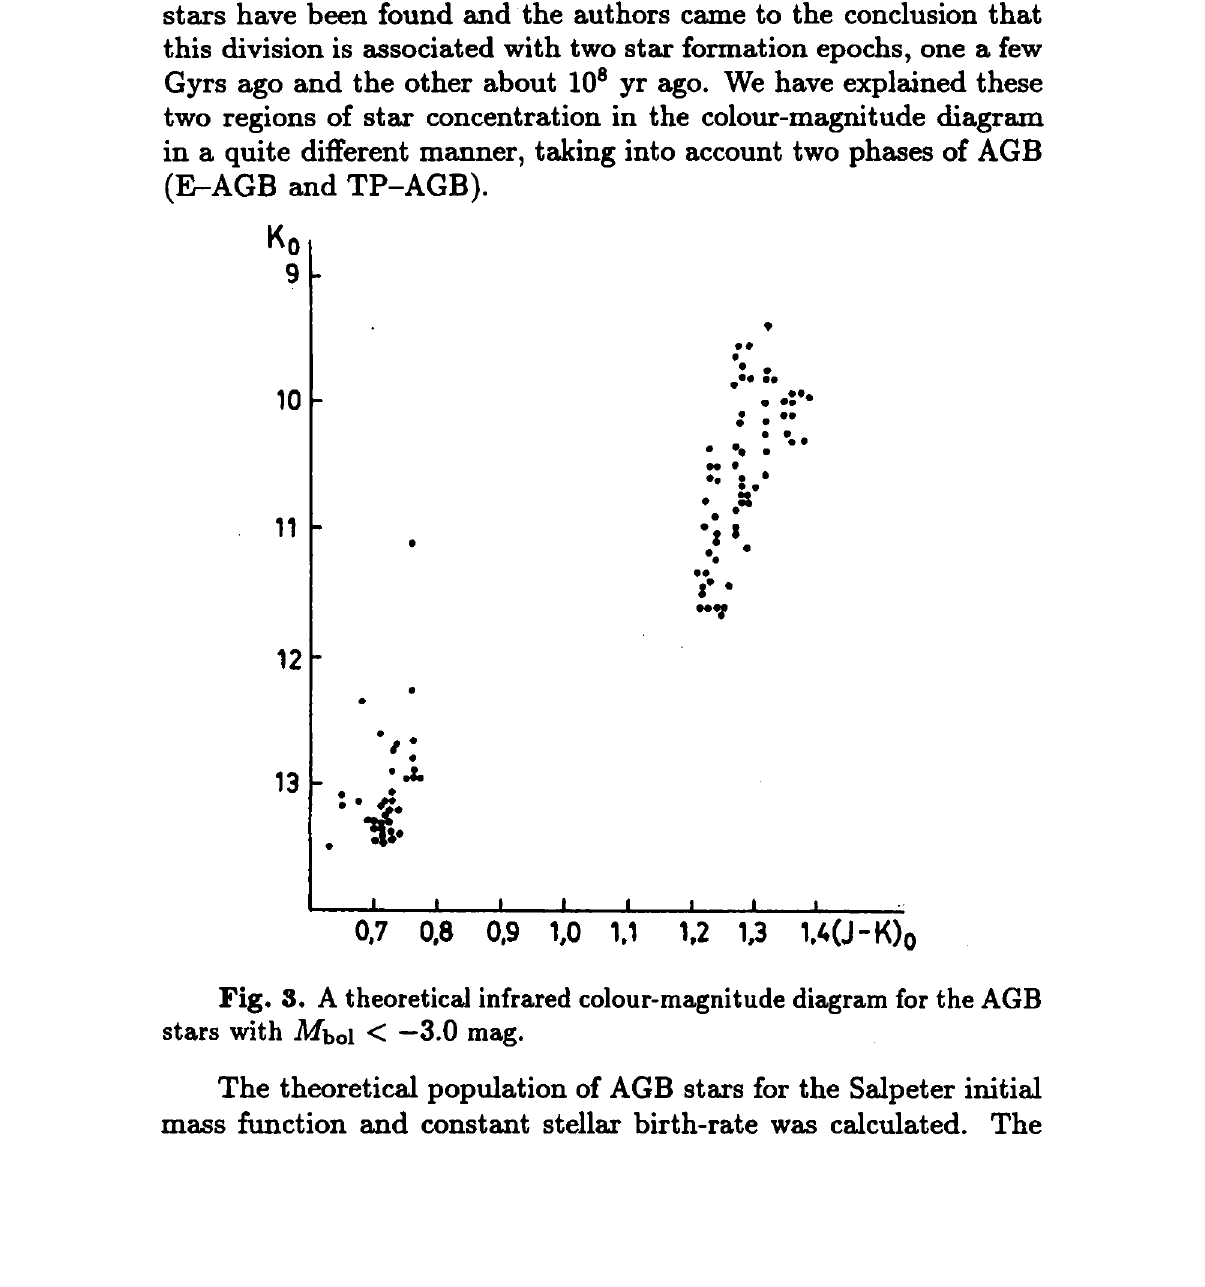
Fig. 3. A theoretical infrared colour-magnitude diagram for the AGB stars with M\, \ < —3.0 mag. 0 The theoretical population of AGB stars for the Salpeter initial mass function and constant stellar birth-rate was calculated.